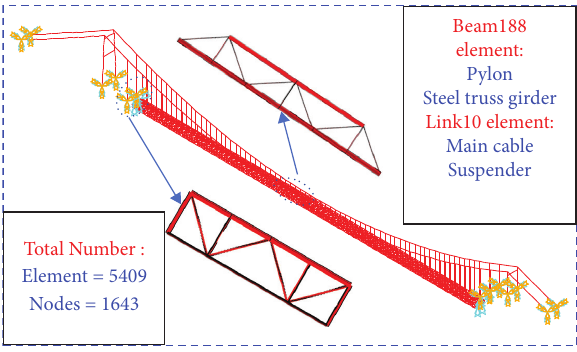
Figure 3: FE model of the Aizhai Bridge. Table 3: The vibration modes of the Aizhai